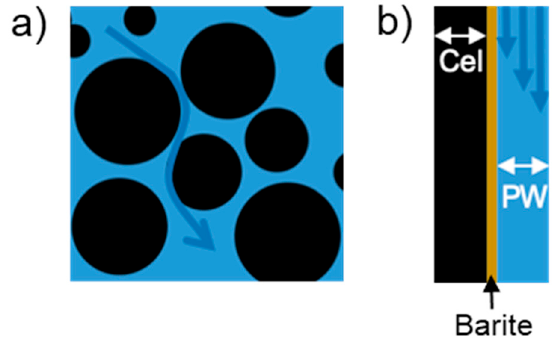
Figure 2. ( a ) Schematic of fluid flow in porous media, and ( b ) a simplified model following a streamline, the so-called flat channel scenario.